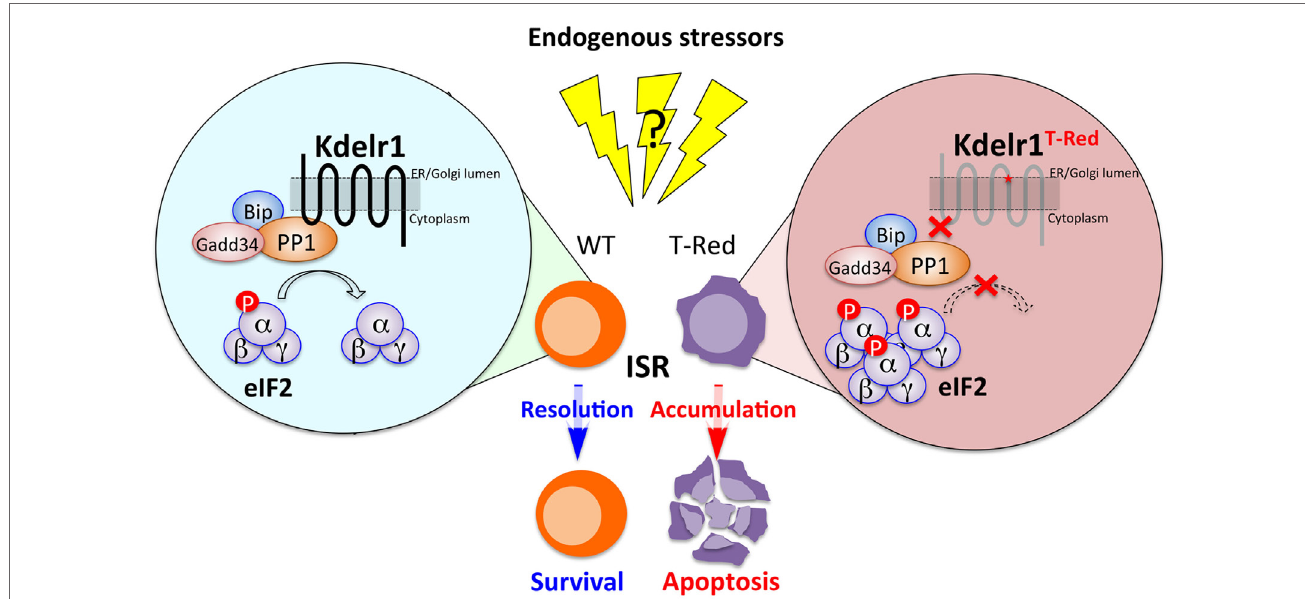
FiGURe 1 | The Kdelr1–PP1 axis is required for naïve T cell survival . In WT naïve T cells, PP1 associated with Kdelr1 exhibits optimal phosphatase activity to prevent unwanted persistence of ISR. In T-Red naïve T cells, however, Kdelr1 dysfunction results in reduced PP1 activity, leading to prolonged ISR and apoptosis. Endogenous factors that cause ISR in vivo remain